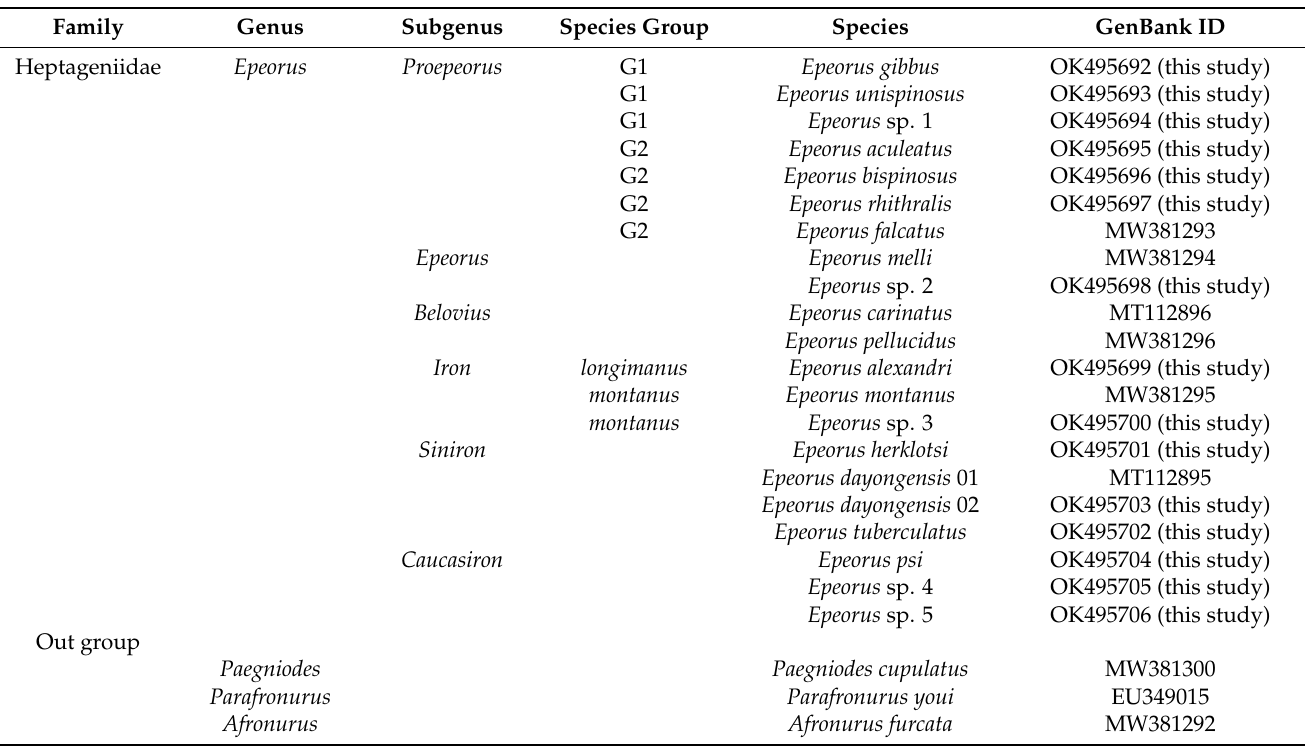
Table 1. GenBank accession numbers of species used in this